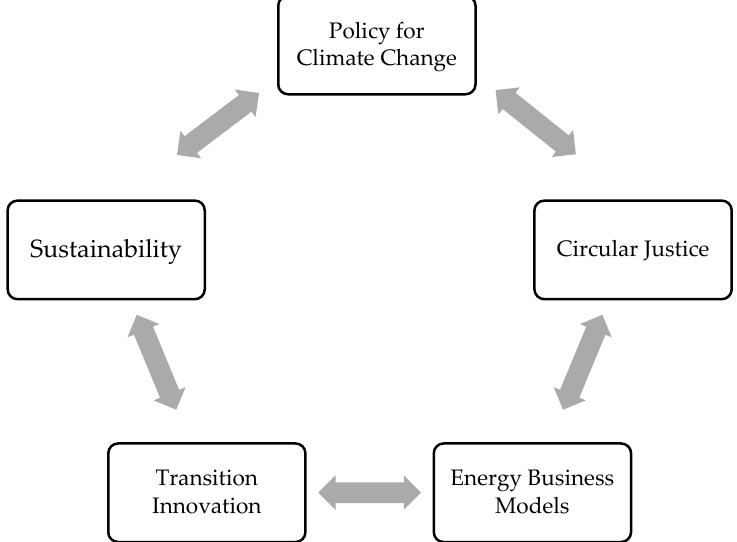
Figure 19. Major future agenda topics in relation to the main challenges facing society.